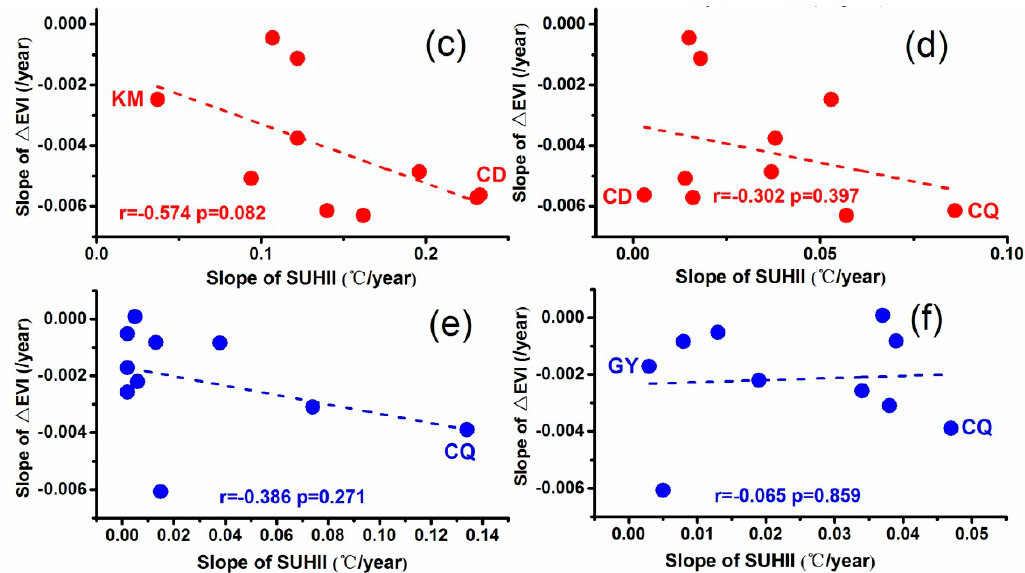
Figure 7. Correlation analyses between linear slope of SUHII and ∆ EVI: ( a ) annual daytime; ( b ) annual nighttime; ( c ) summer daytime; ( d ) summer nighttime; ( e ) winter daytime; ( f ) winter nighttime. Each dot represented a city.